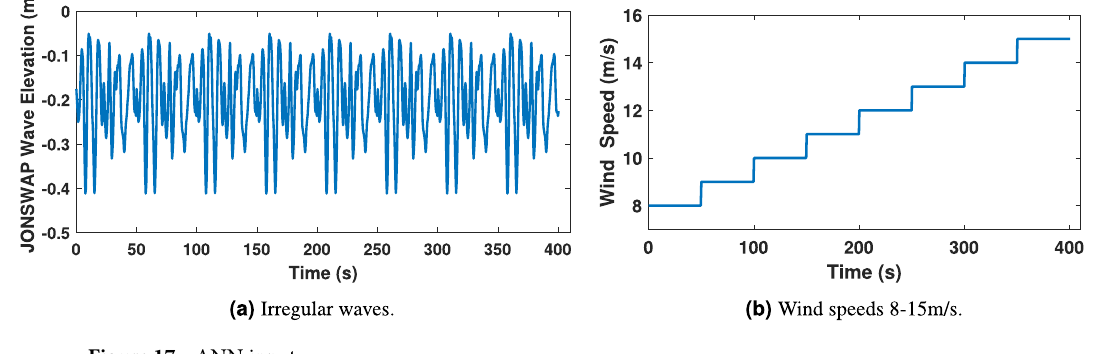
Figure 17. ANN input.